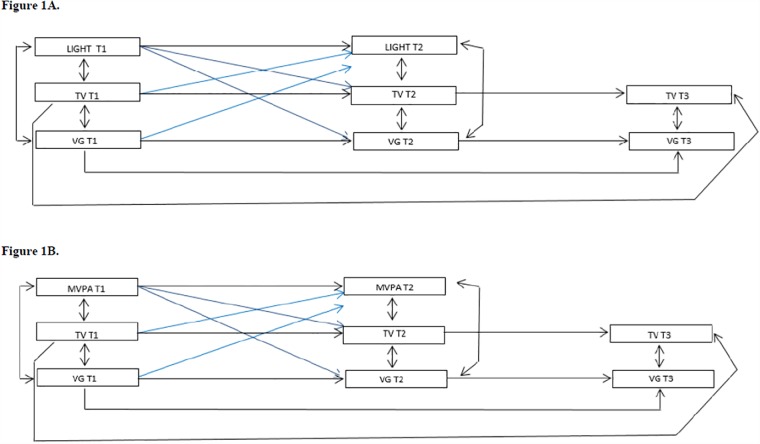
Logic models.(1a) Model A for light physical activity (PA); (1b) Model B for moderate and vigorous physical activity (MVPA). The Adolescent Nutritional Assessment Longitudinal Study, 2010–2012, Brazil.